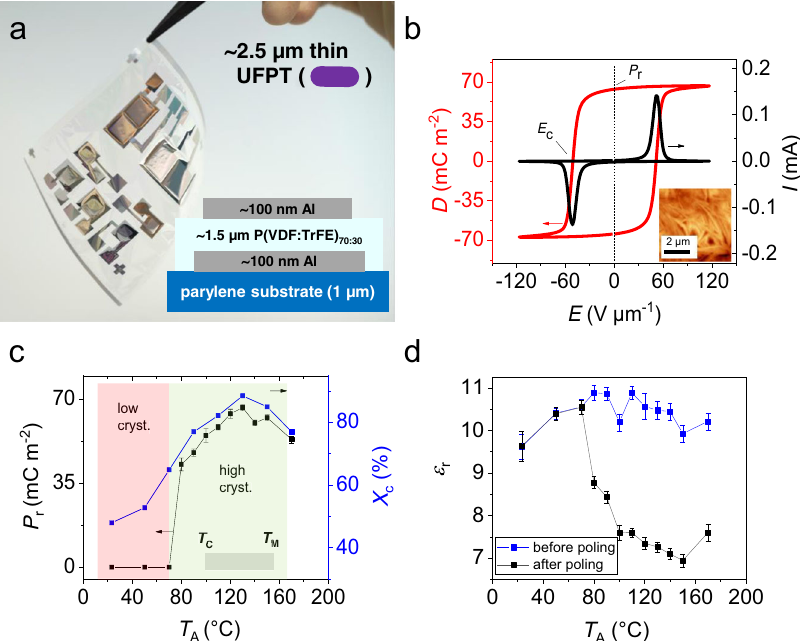
Fig. 2 Ultra fl exible ferroelectric polymer transducer (UFPT) setup, and the ferroelectric and dielectric properties. a Photograph of the ultra fl exible P(VDF:TrFE) 70:30 -based transducer with a 1- µ m thin diX-SR (parylene) substrate and the illustration of its setup. b Representative D(E) hysteresis curve of the ferroelectric layer measured during poling at 1 Hz after annealing at 130 °C. E c denotes the coercive electric fi eld strength where most microscopic dipoles start to rearrange themselves under the presence of an applied external fi eld, and P r is the remnant polarisation in the absence of an external fi eld (i.e., D ( E = 0 V µ m − 1 )), which is the main fi gure-of-merit for the transducer. c P r and degree of crystallinity X c as a function of the annealing temperature T T 71 and the Curie temperature T A . The melting point ( M ) was reported earlier to be 153 °C C was measured to be ~ 105 °C (see Supplementary Fig. 2). d The dependence of ε r (mean value) on T A measured before and after poling. The displayed values of P r and ε r for each T A in ( c ) and ( d ) are mean values with standard deviations determined from at least ten devices with layer thickness values between 1.3 and 1.5 µ